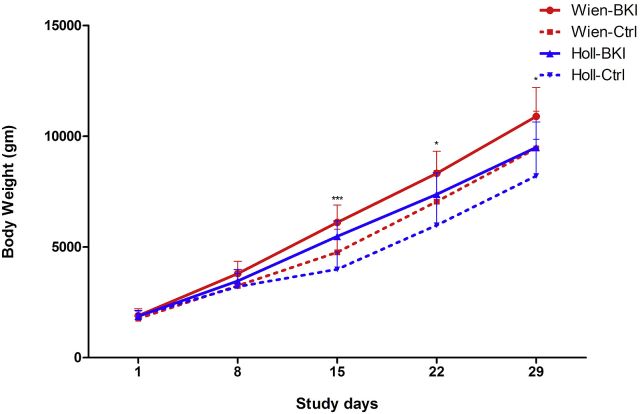
Body weight development in piglets after BKI 1369 treatment. Vertical lines depict standard deviations.